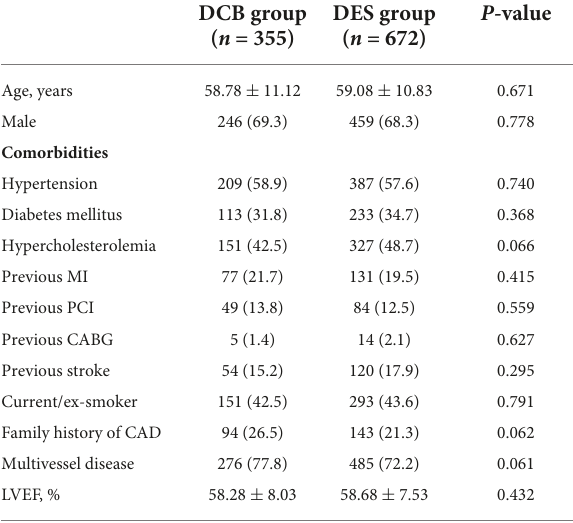
TABLE 1 Baseline patient